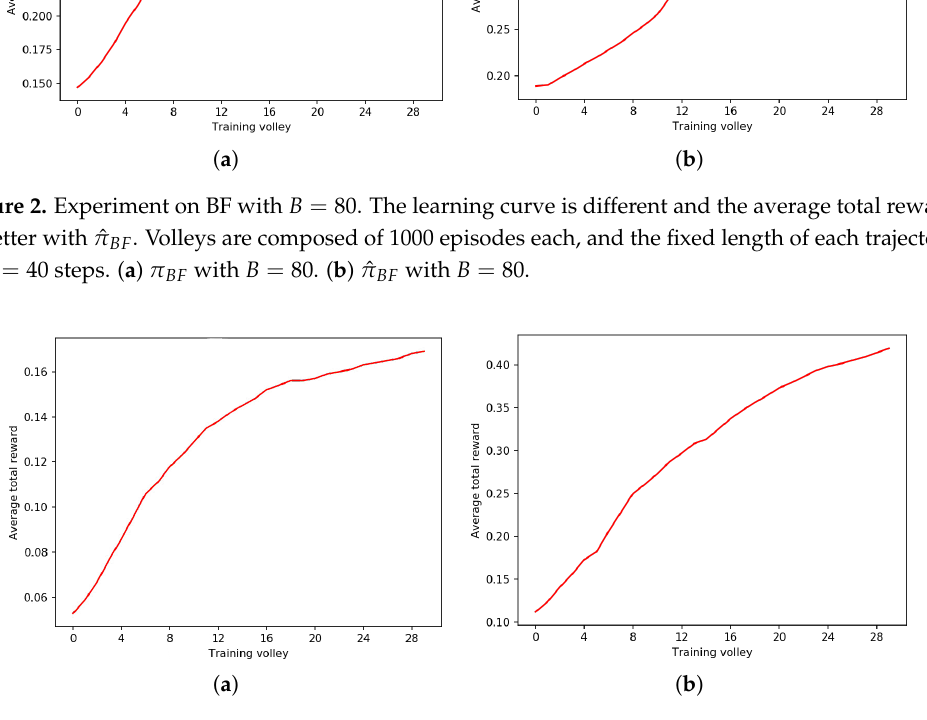
Figure 3. Experiment on BF with B = 200. Despite the similar learning curve, there is a huge difference in the achieved average total reward per episode between ˆ π BF and π BF at the end of the training process. Volleys are composed of 1000 episodes each and the fixed length of each trajectory is T = 100